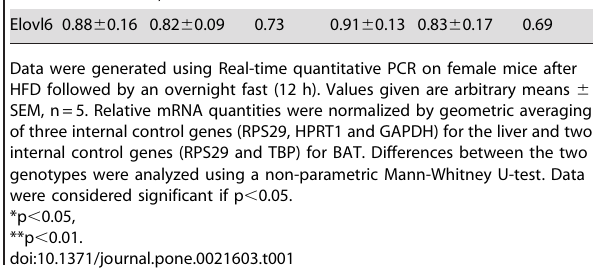
( Figure 2C,D ). The lowered ratio of 16:1n7/16:0 fatty acids (0.70, p , 0.05) seen in plasma TAG ( Figure 2E ) and the